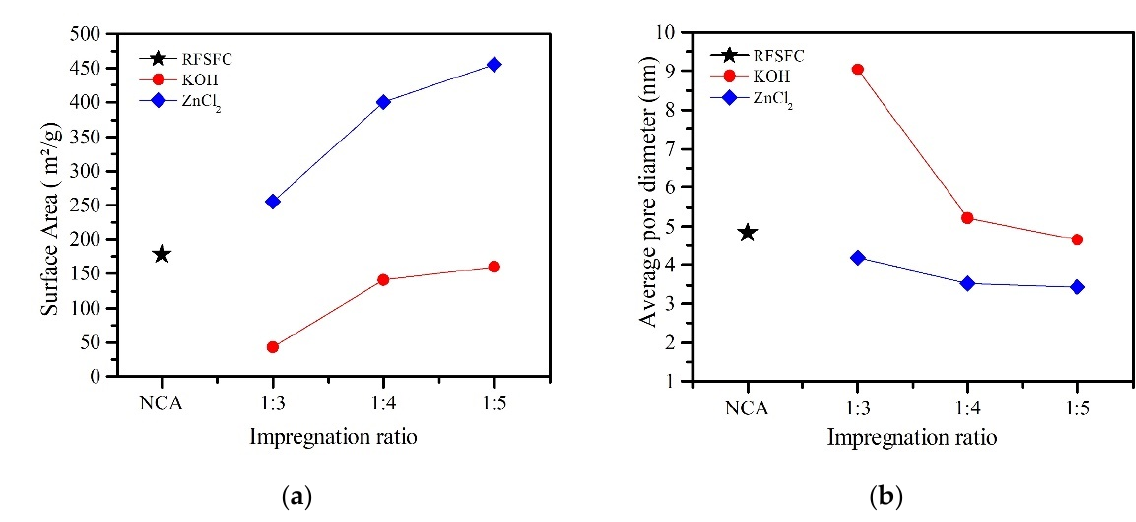
Figure 3. ( a ) Brunauer–Emmett–Teller (BET) surface area; ( b ) average pore diameter of treated RFSFAC, with different activating agents and impregnation ratio. (NCA, non-chemical activation). Table 3. Textural properties of